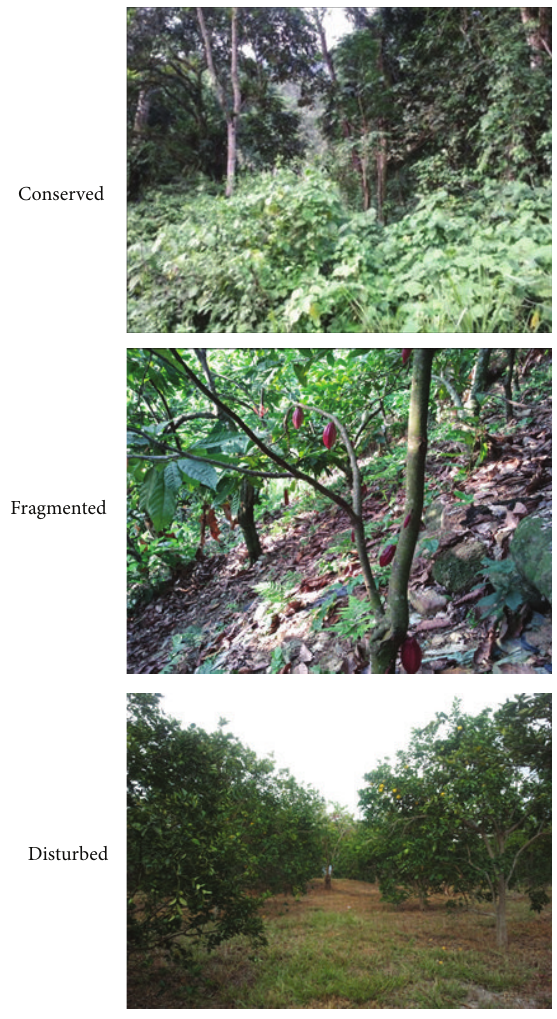
Figure 1: Different degrees of ecological disturbance of the agroe-